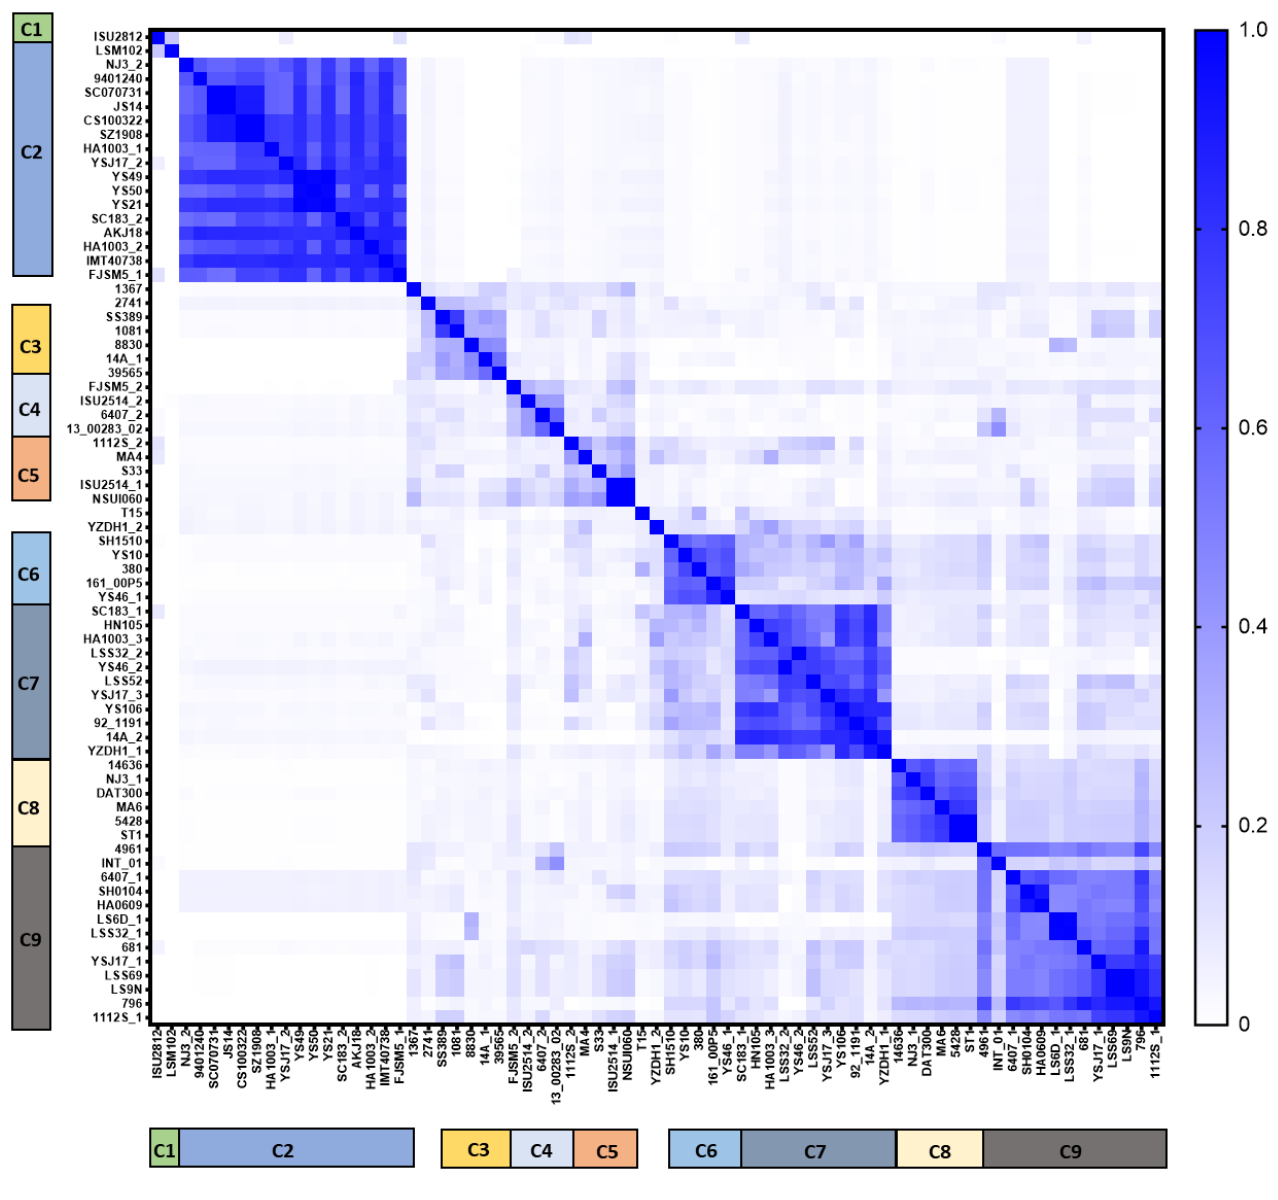
Figure 4. Whole proteomic heatmap of the 71 full-length S. suis prophages. Nine clusters (C1–C9) and four singletons were identified. Members within each cluster share ≥ 50% ( ≥ 0.5) proteomic identity. Scale bar on the right represents sequence identity. Blue (1.0) represents highest identity, and white (0) represents no proteomic pairwise identity.